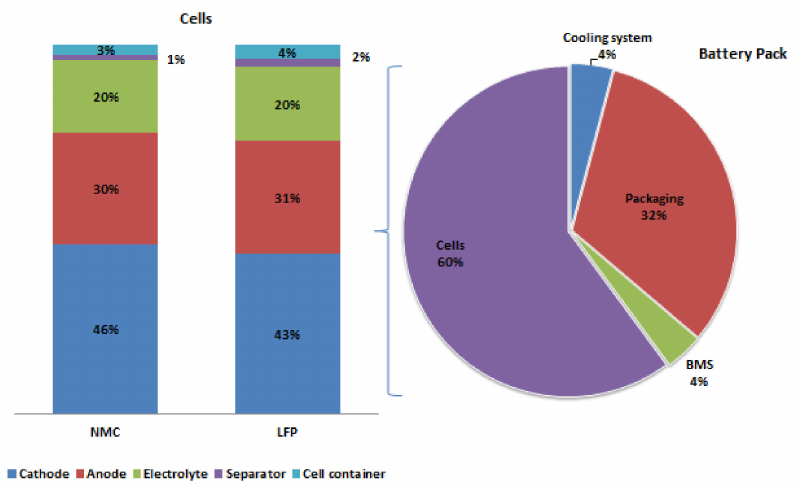
Figure 3. Battery pack and battery cell mass composition, by components. LFP: lithium–iron– phosphate; NMC: